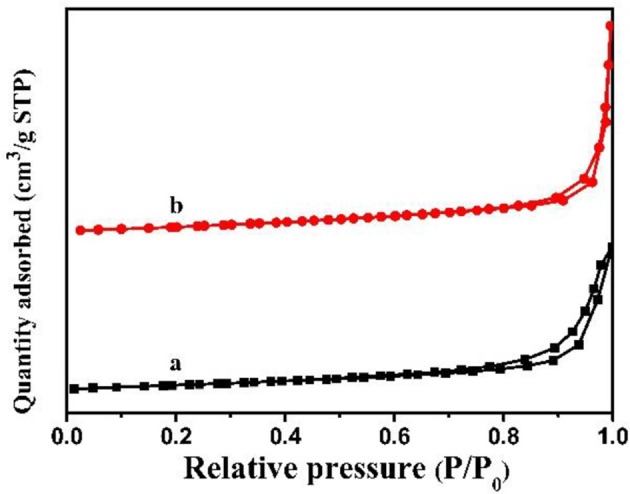
N2 adsorption-desorption isotherms of (a) MCN and (b) Na-CMCN.